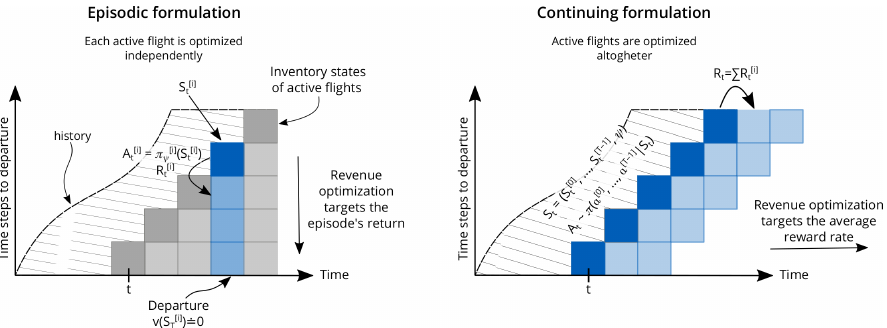
Figure 3. Comparison between episodic and continuing formulations for revenue